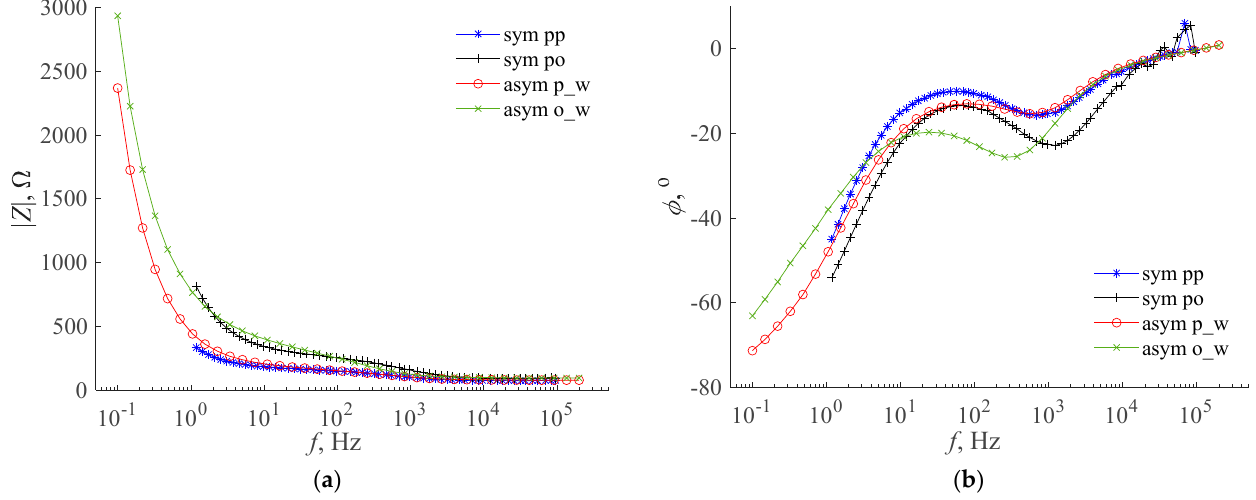
Figure 9. Measurement frequency characteristics of: ( a ) modulus and ( b ) argument of impedance of the tested symmetric supercapacitors containing NBu 4 ClO 4 as the active electrolyte component. Figure 10 shows the measurement and approximation characteristics, for example, for a symmetrical supercapacitor with collectors containing polypyrrole, containing LiClO 4 as the active electrolyte component.